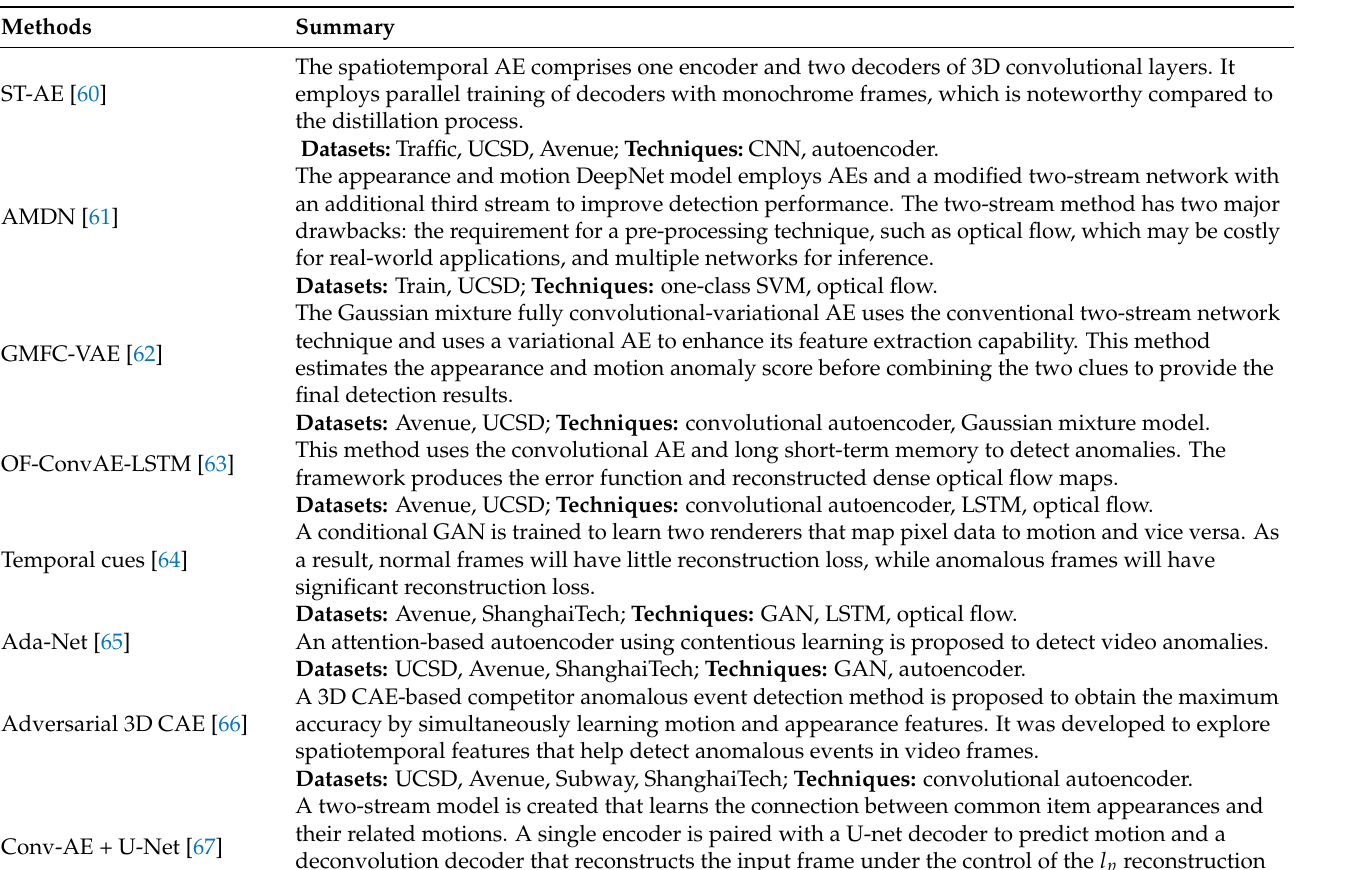
Table 4. Reconstruction-based